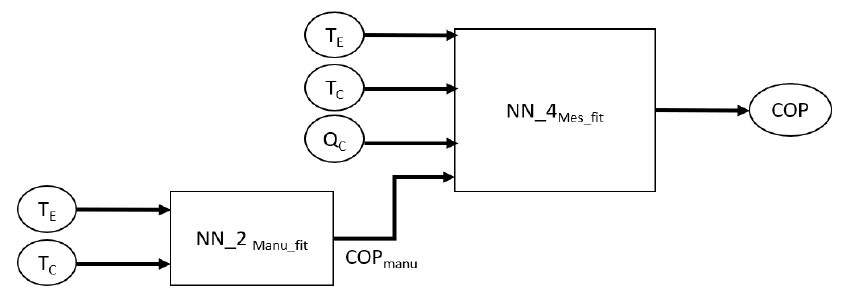
Figure 6. Schematic of the ANN model that includes manufacturer’s coefficient of performance (COP) as input.